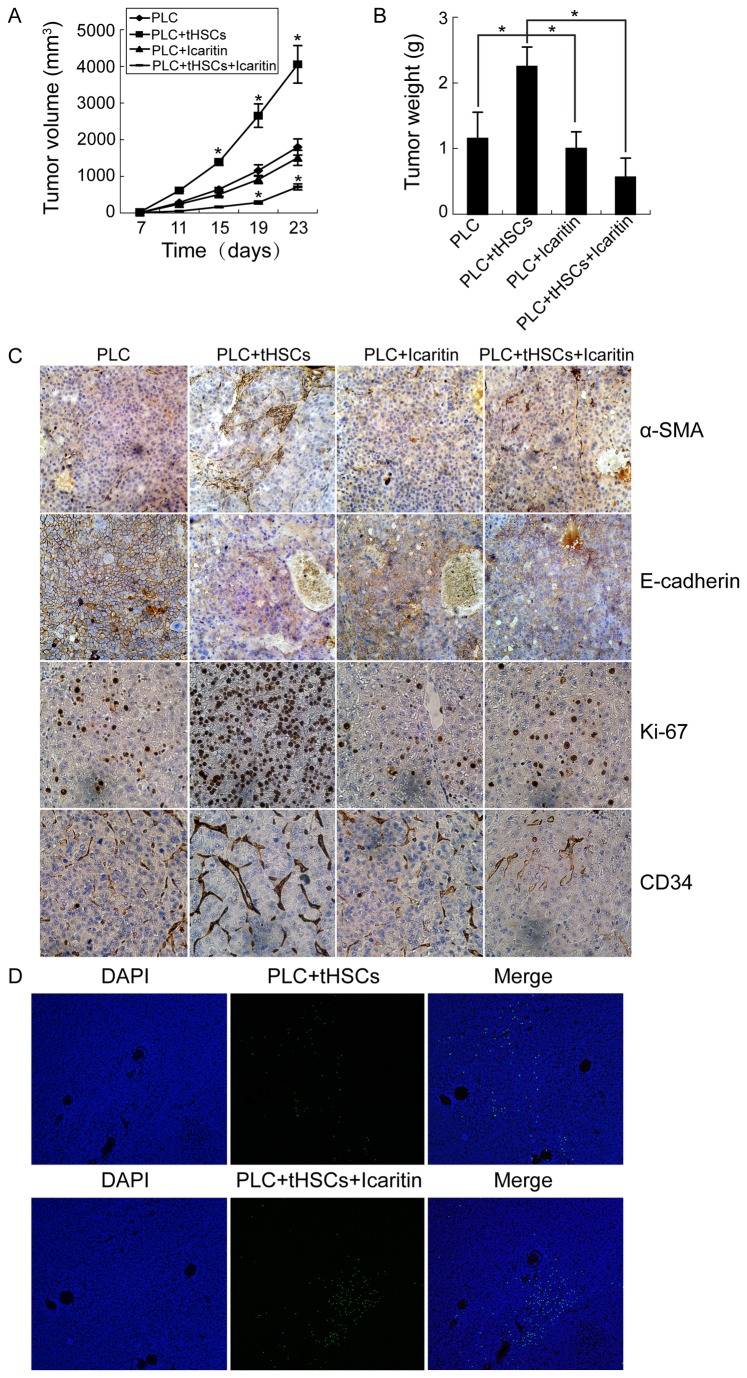
tHSCs promote HCC growth, and icaritin effectively inhibits tHSC-induced HCC-promoting effects in vivo.(A) The tumor volumes were monitored every 4 days up to 23 days after cell implantation. (B) The tumor weights at the end of experiments (*p < 0.05). (C) Representative immunohistochemical staining of α-SMA, E-cadherin, Ki-67, and CD34 expressions in different xenografts. (D) Representative images of TUNEL assay in different xenografts (magnification, ×200). PLC: PLC/PRF/5.